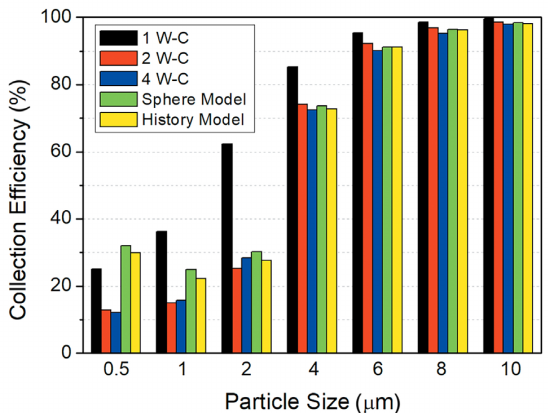
Figure 7. Grade efficiency predicted by the CFD simulation of Sgrott and Sommerfeld [108] for a pilot-scale cyclone loaded with particles with a diameter of 0.5–60 microns and a mass loading of 0.1 kg s /kg g . 1 W-C, 2 W-C, and 4 W-C refer to one-way coupling, two-way coupling, and four-way coupling methods (using CFD–DEM without agglomeration), respectively. Sphere and history models are volume-equivalent and inertia-equivalent approaches for agglomeration,